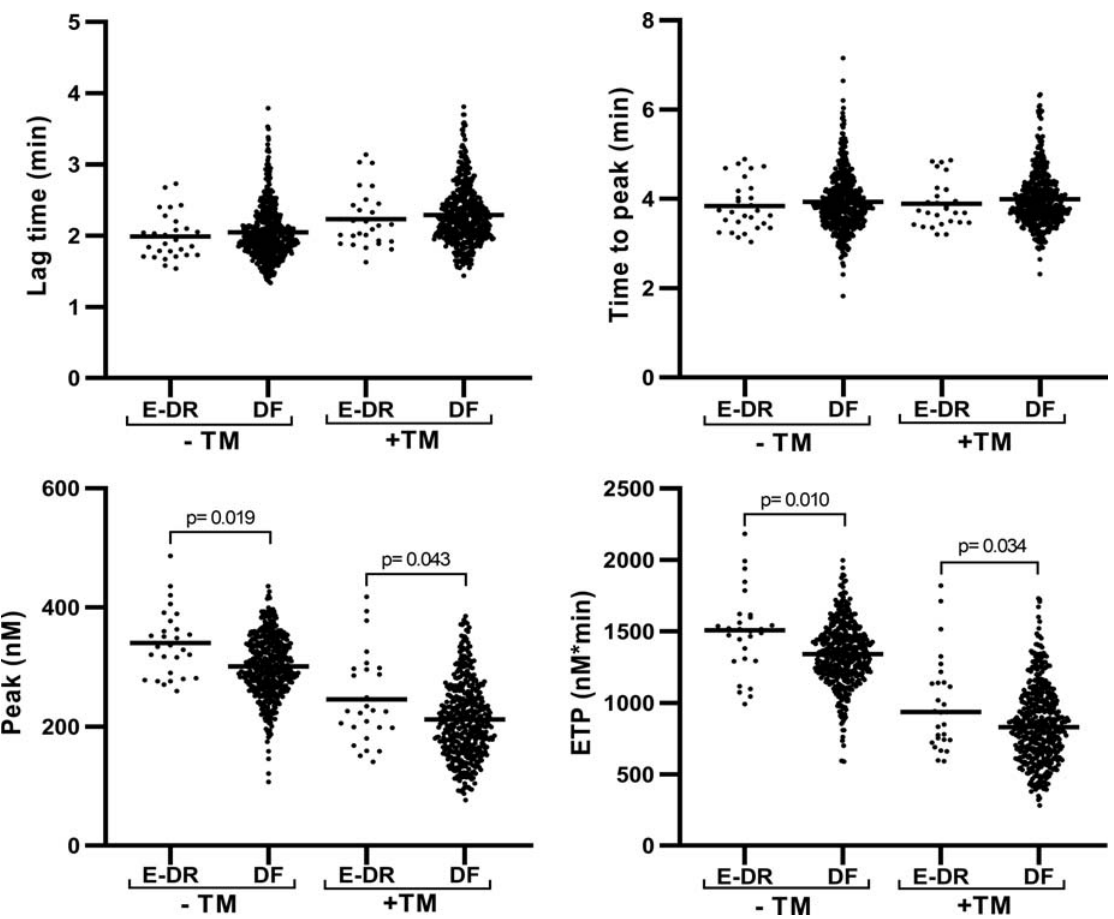
Fig. 2 Thrombin generation parameters in the absence and presence of thrombomodulin according to early disease recurrence. ETP, endogenous thrombin potential; TM, thrombomodulina; E-DR, early disease recurrence; DF, disease free. Table 3 Cox regression multivariable analysis for early disease recurrence including absolute and normalized